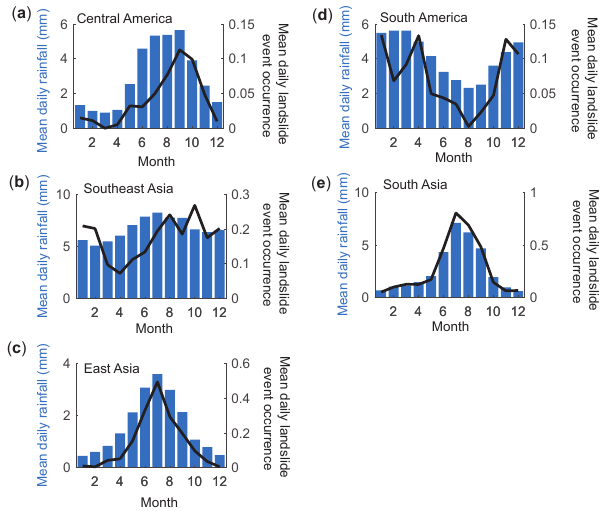
Figure 5. Mean daily rainfall (in millimetres) by month between 2004 and 2016, summarised by geographical subregion (blue bars). Global Precipitation Climatology Centre data (Xie et al., 2013; GPCC, 2018) were processed in ESRI ArcMap and MATLAB. Mean daily rainfall-triggered landslide event occurrence by month between 2004 and 2016 (black line). Daily values are used to over- come the difference in month